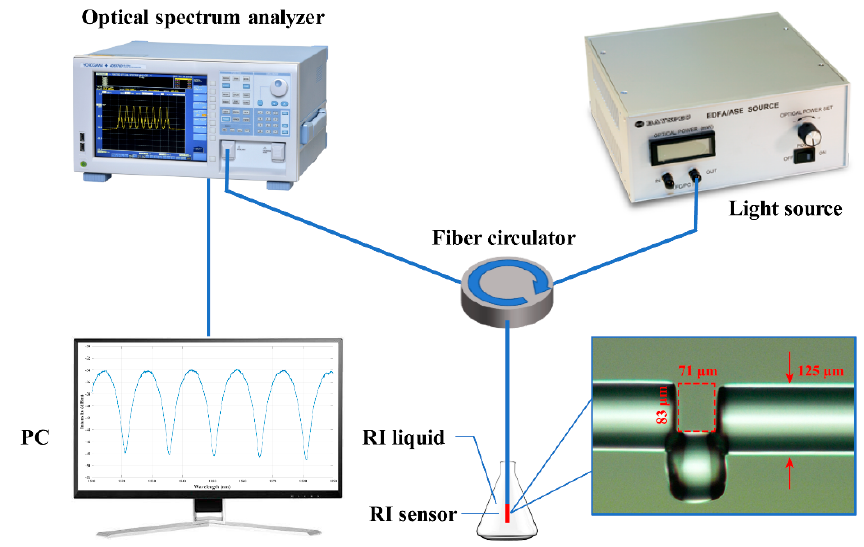
Figure 4. Experimental setup for liquid refractive index sensing. Insert, the micrograph of EFPI sensor.